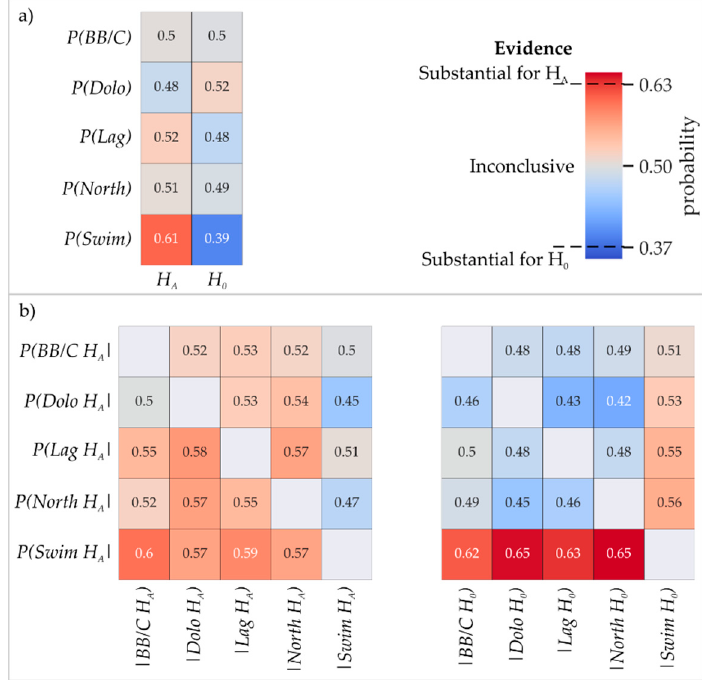
Figure 4. Simple ( a ) and conditional ( b ) posterior probabilities of hypotheses concerning uncertain water balance components. (b) Should be read: probability of row, given column (e.g., P(Dolo H A | North H A ) ). In (b) the inverse probability (not shown here) is P(X H 0 | Y H A ) = 1 − P(X H A | Y H A ) and P(X H 0 | Y H 0 ) = 1 − P(X H A | Y H 0 ) , respectively. All started with uniform probability (0.5). In Figure 2, names in Northern boundary and Swim = Swim